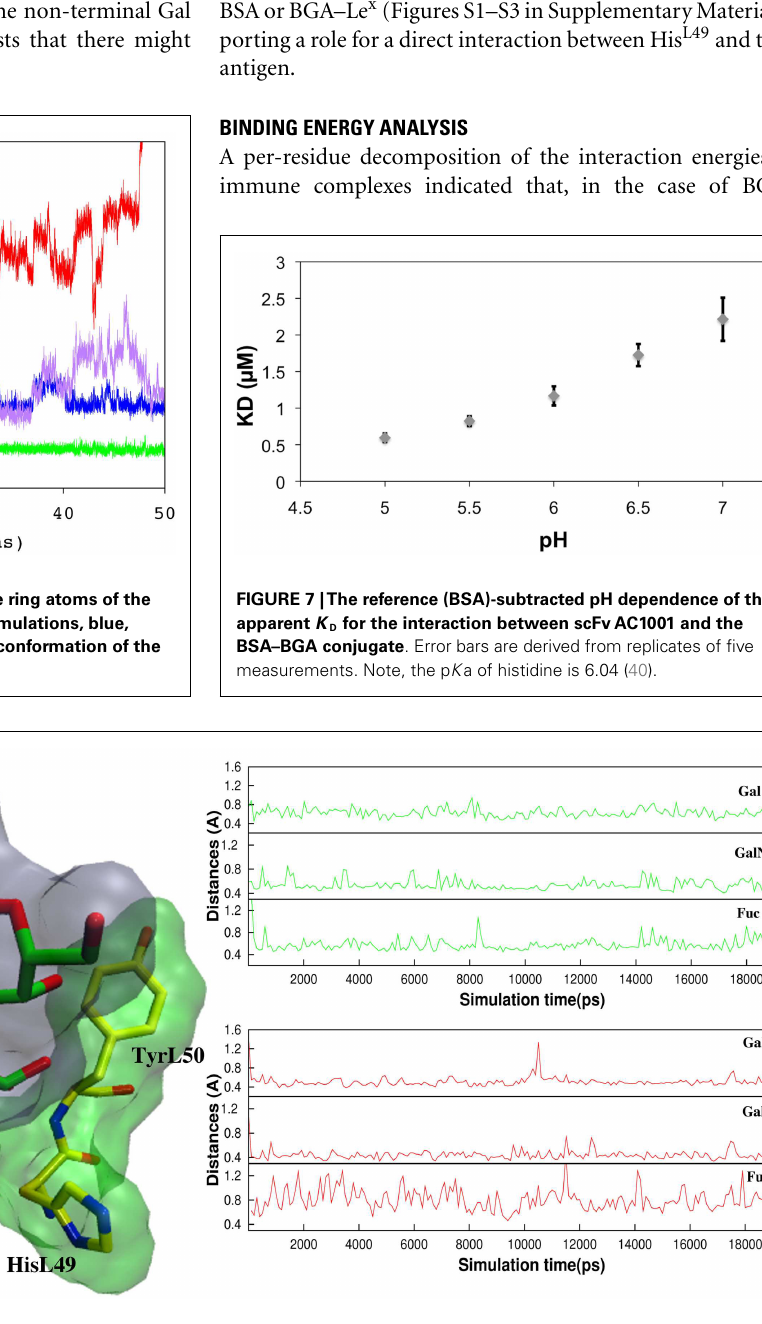
FIGURE 6 | (Left) The antigens are flanked byTyr L50 , Asn L34 , and His L49 (Group 1, green surface), andTrp H100 andTrp L96 (Group 2, pink surface). Fuc interacts with Gly L91 and Asn L92 (Group3, yellow surface). (Right) Atomic fluctuations of residues Gal, GalNAc/Gal (BGA/BGB), and Fuc as a function of